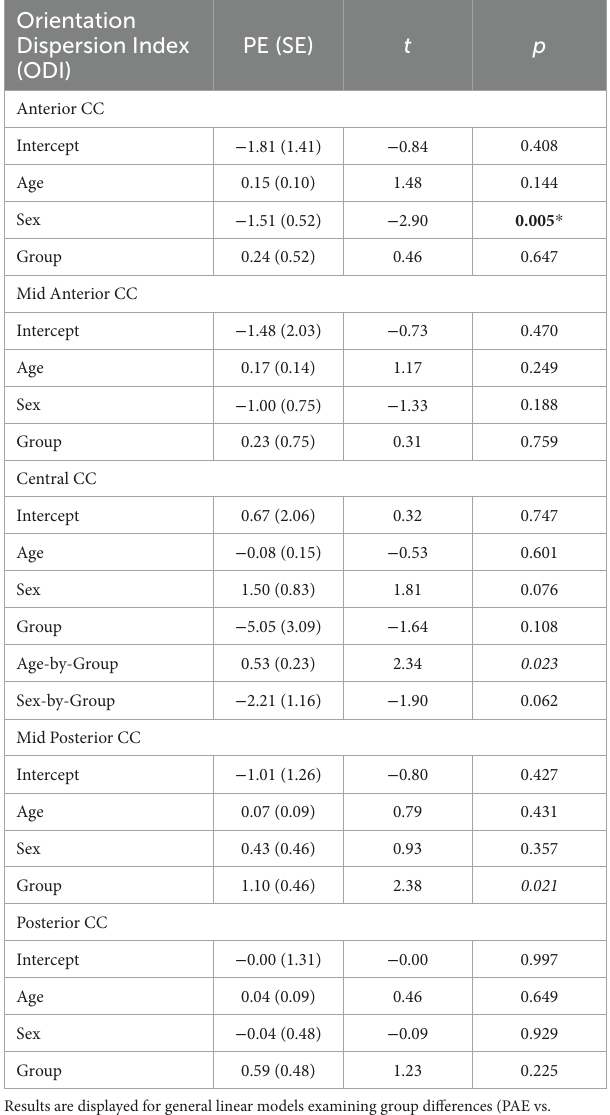
TABLE 6 General linear model results for SPC in ODI. Orientation Dispersion